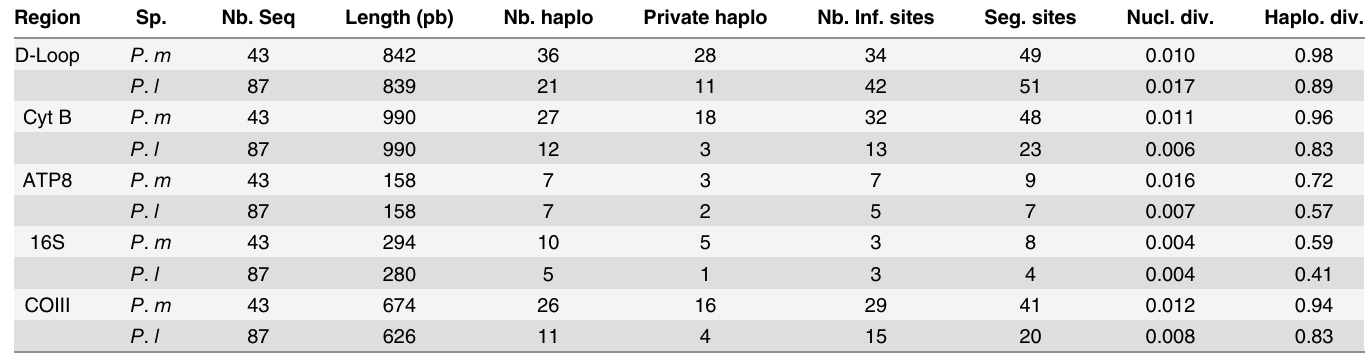
Table 3. Numbers of sequences, sequence lengths (pb), numbers of haplotypes, private haplotypes, informative sites, segregating sites, nucleo- tide diversity and haplotype diversites for each mtDNA region used in this study for the species (sp) P . leucopus ( P . l ) and P . maniculatus ( P . m ).